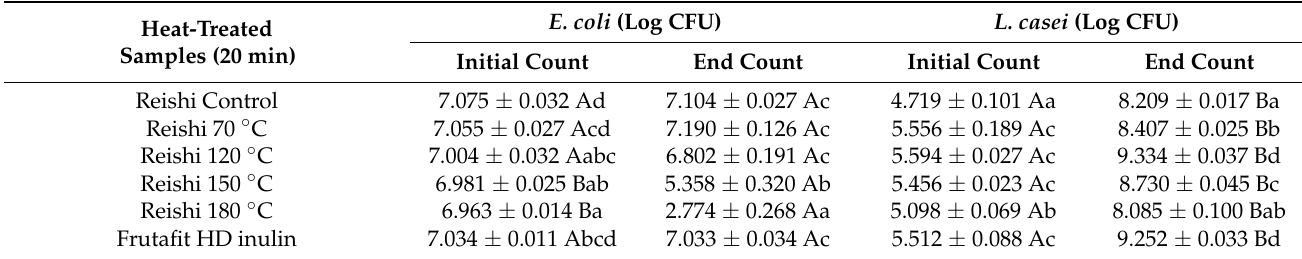
Table 2. The effect of heat-treated Reishi mushroom samples on the in vitro growth rate of L. casei and E. coli (mean ± StDev).